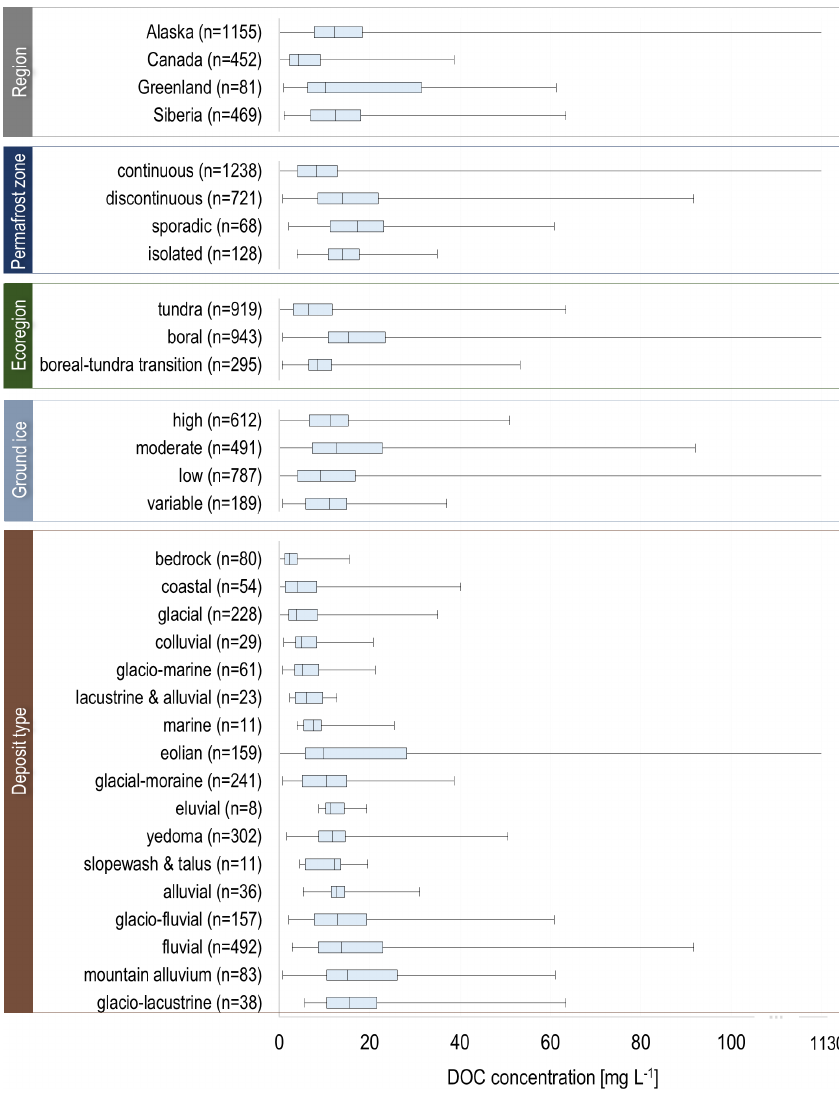
Figure 3. Dissolved organic carbon (DOC) concentration (mgL − 1 ) of lakes in different Arctic regions, permafrost zones, ecoregions, ground ice content, and deposit types. Note that the x axis is interrupted between 100 and 1130mgL − 1 to visually capture the wide range of the DOC